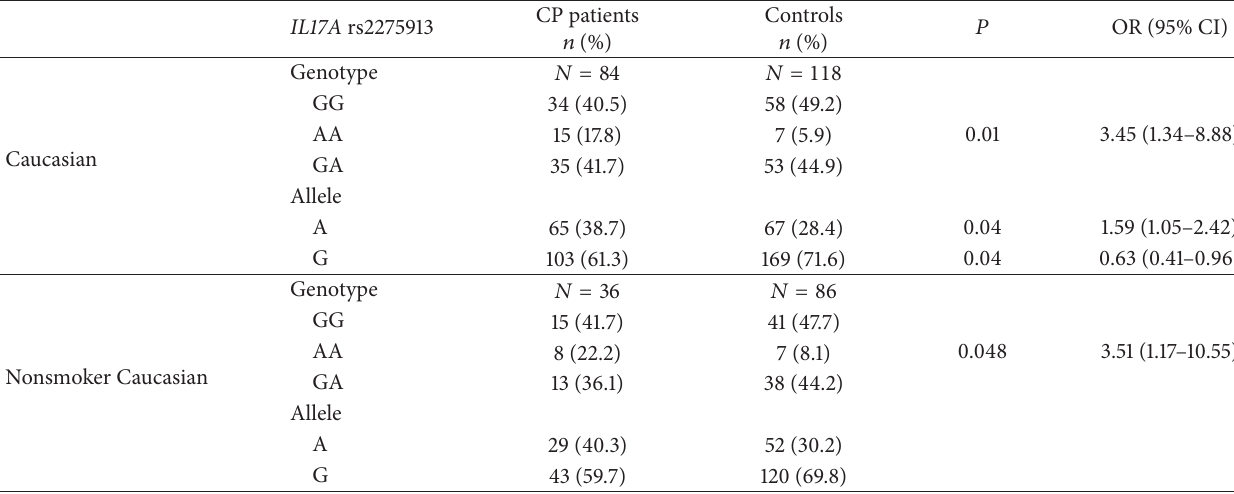
Table 4: IL17A genotype and allele frequencies in chronic periodontitis Brazilian patients and controls stratified according to ethnic group ∗